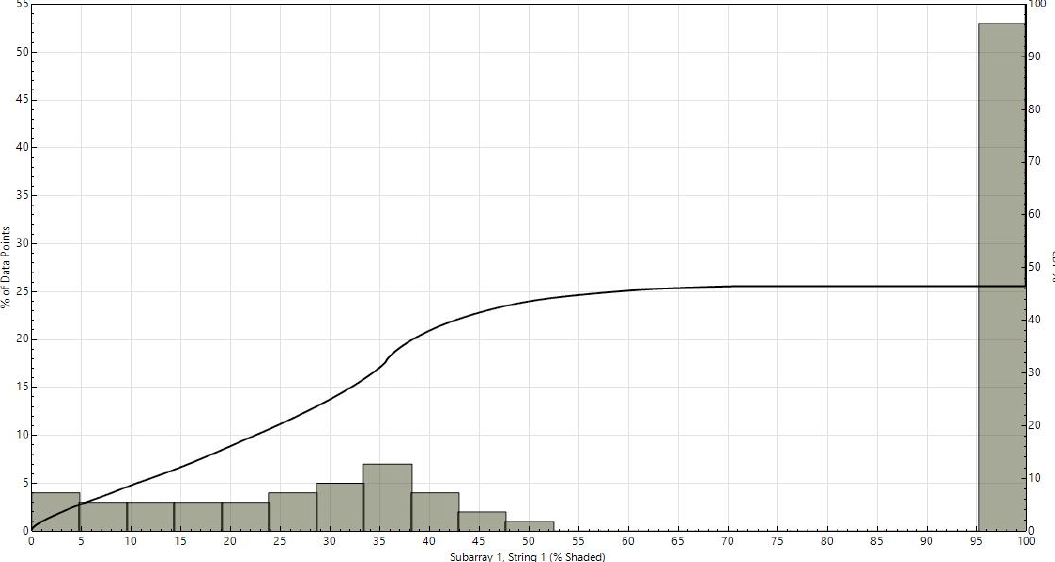
Figure A4. Time series (1 min step) shaded fraction histogram (zero-values excluded) for due southwest orientation.